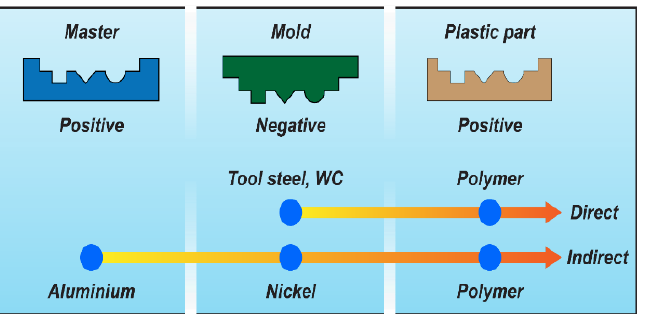
Figure 1. Examples of a direct and indirect tooling process chain. Reproduced with permission from [3].